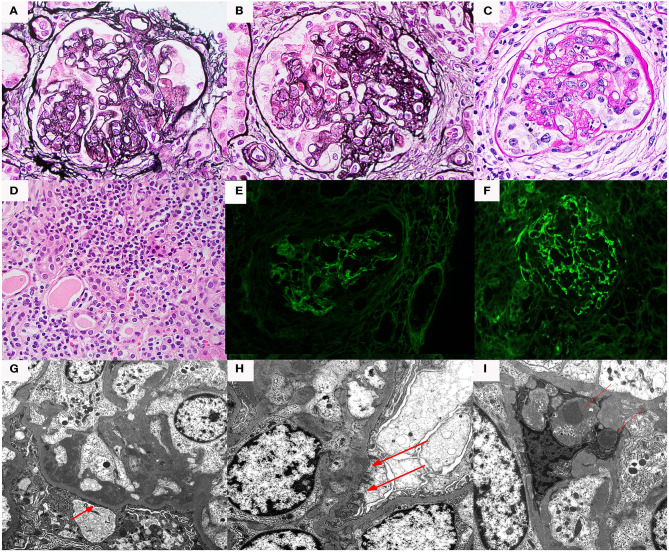
Renal biopsy data for Case 1: (A) light microscopy 40× silver stain Double contours and segmental scar; (B) light microscopy 40× silver stain Double contours with endocapillary hypercellularity and segmental scar; (C) light microscopy 40× hematoxylin and eosin cellular crescent with segmental karyorrhexis; (D) light microscopy 40× hematoxylin and eosin tubulointerstitial inflammation; (E) immunofluorescence IgG staining; (F) immunofluorescence showed C3 staining > IgG staining. (G) Electron microscopy, subendothelial deposits (red arrows); (H) electron microscopy, subepithelial deposits (red arrows); (I) electron microscopy, mesangial deposits (red arrows).